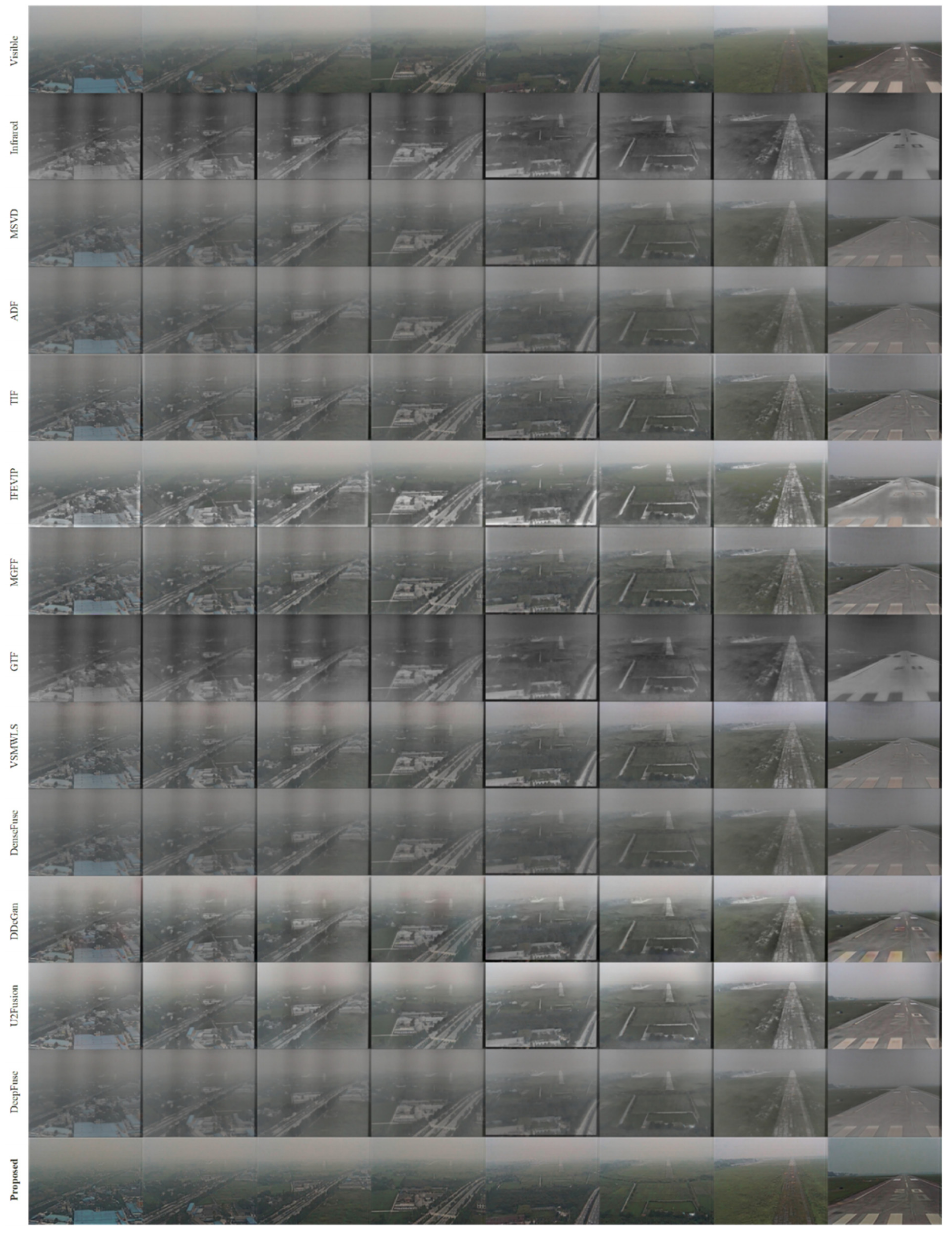
Figure 7. Qualitative fusion results of different